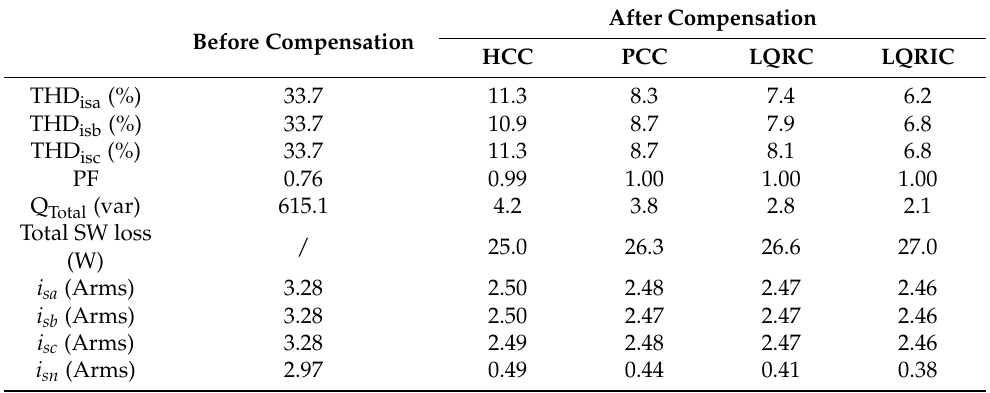
Table 2. Simulation results before and after LC -HAPF compensation under 50V DC-link